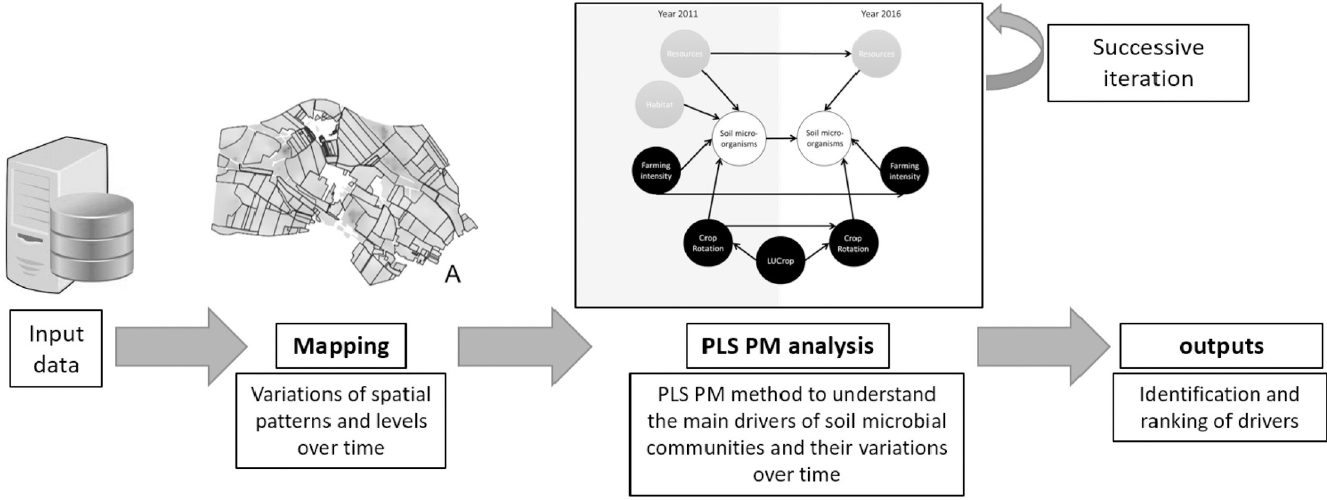
Fig 2. Analytical workflow. Two main analyses were led: 1) a mapping step identified the variations of the spatial patterns of our variables and potential variations of the levels; 2) a second step based on a PLS PM method identified the main drivers of soil microbial communities and their evolution over time based on the different variables. This part was led with an iterative method where measurable variables, architecture and the significance of interactions were evaluated.